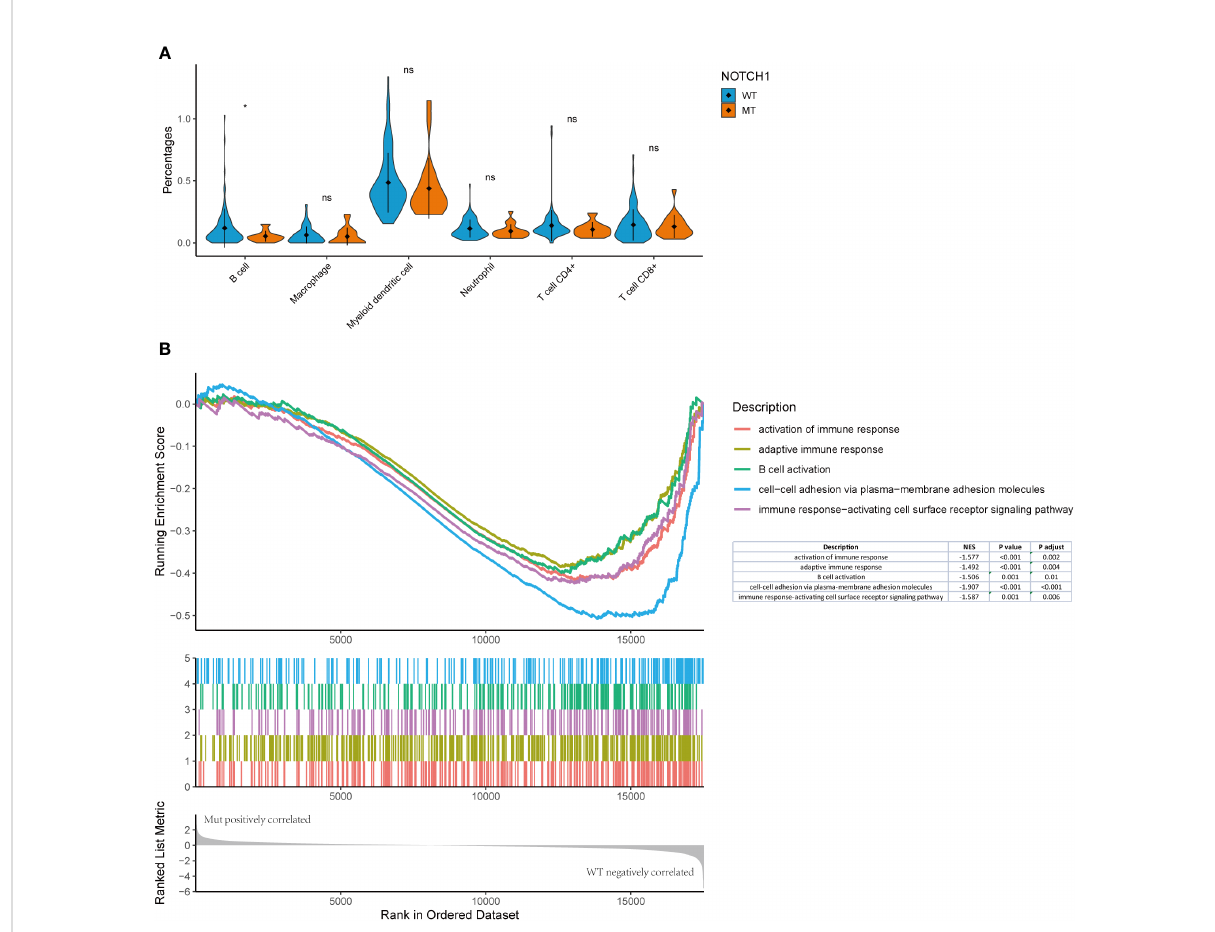
FIGURE 7 NOTCH1 mutation status was correlated with immune in fi ltration in the laryngeal cancer datasets from TCGA. (A) TIMER algorithm to estimate the TCGA immune cell in fi ltration status in laryngeal cancer datasets. (B) The GSEA results revealed prominent enrichment in discrepant